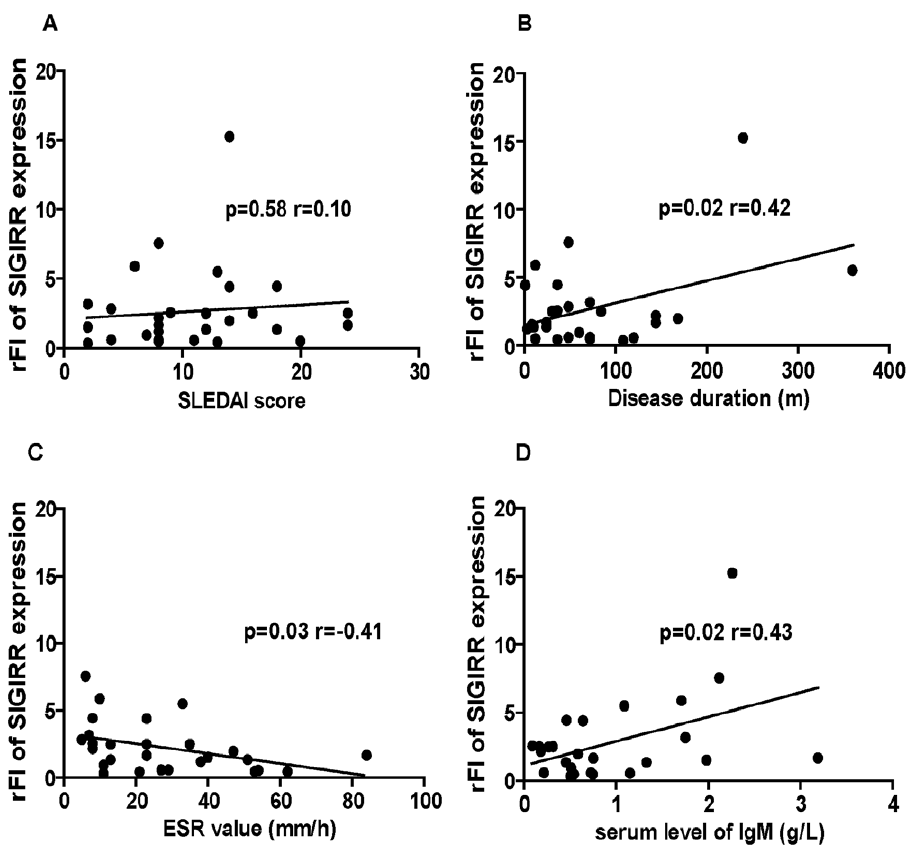
Figure 4. Correlation of SIGIRR expression and clinical features. The correlation between the SIGIRR expression level in B cells and the clinical features of SLE patients, including SLEDAI score (A), disease duration (B), ESR value (C) and serum IgM (D) was analyzed by Pearson’s correlation test. The inserted numbers show the p and r values.